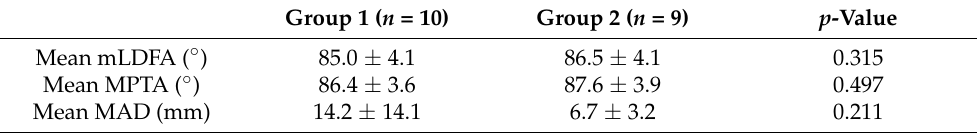
Table 3. The postoperative radiographic measurements at the latest outpatient visit.